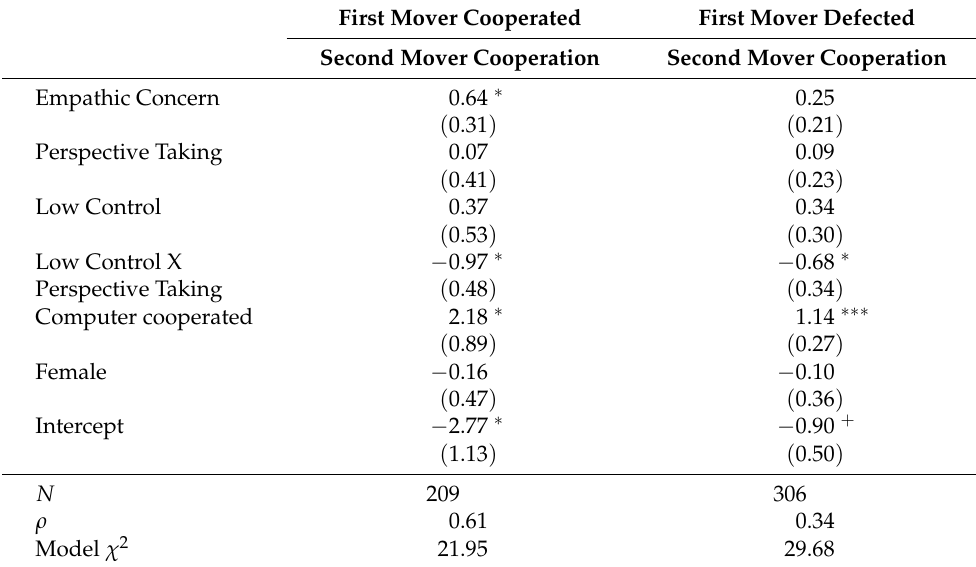
Table 5. Conditional Cooperation in Known Treatment with Empathy and Perspective Taking.